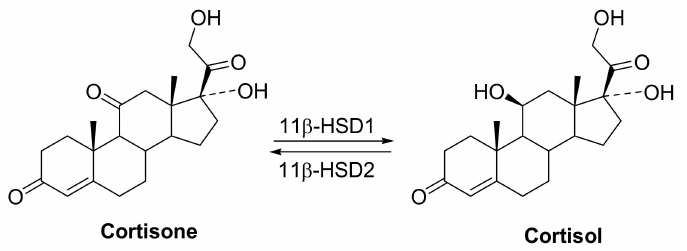
Figure 2. The reactions catalyzed by 11 β -hydroxysteroid dehydrogenase types 1 and